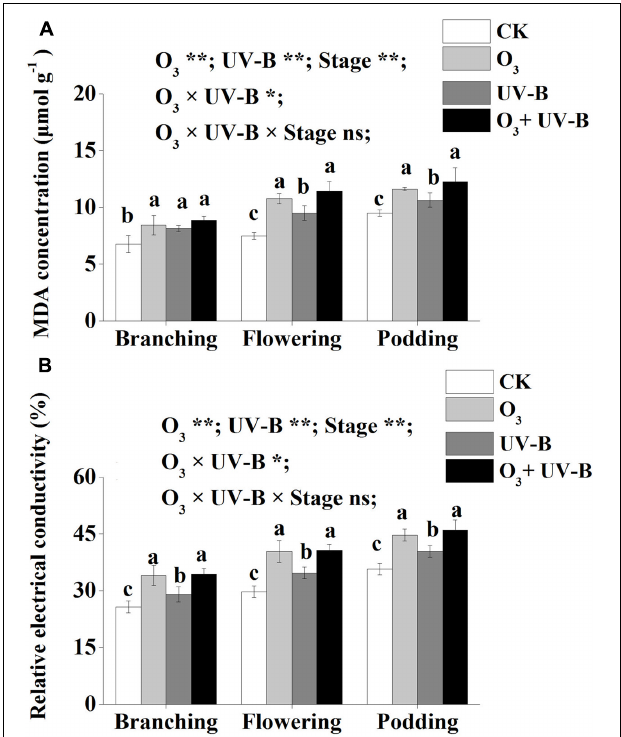
FIGURE 3 | Malondialdehyde concentration ( µ mol g − 1 ) (A) and relative electrical conductivity (%) (B) of soybean roots in response to control treatment (CK), elevated O 3 treatment (O 3 ), enhanced UV-B and O 3 + UV-B treatment (O 3 + UV-B) at stages of branching, flowering and podding. Different letters above the bars represent significant differences from Tukey’s multiple comparisons among four treatments ( P < 0.05). For each parameter, results of three-way ANOVA are reported, with asterisks showing the significance of factors (elevated O 3 treatment (O 3 ), enhanced UV-B and growth stage of soybean (Stage)] and their interaction for: ∗∗ P < 0.001, ∗ P < 0.05; ns,